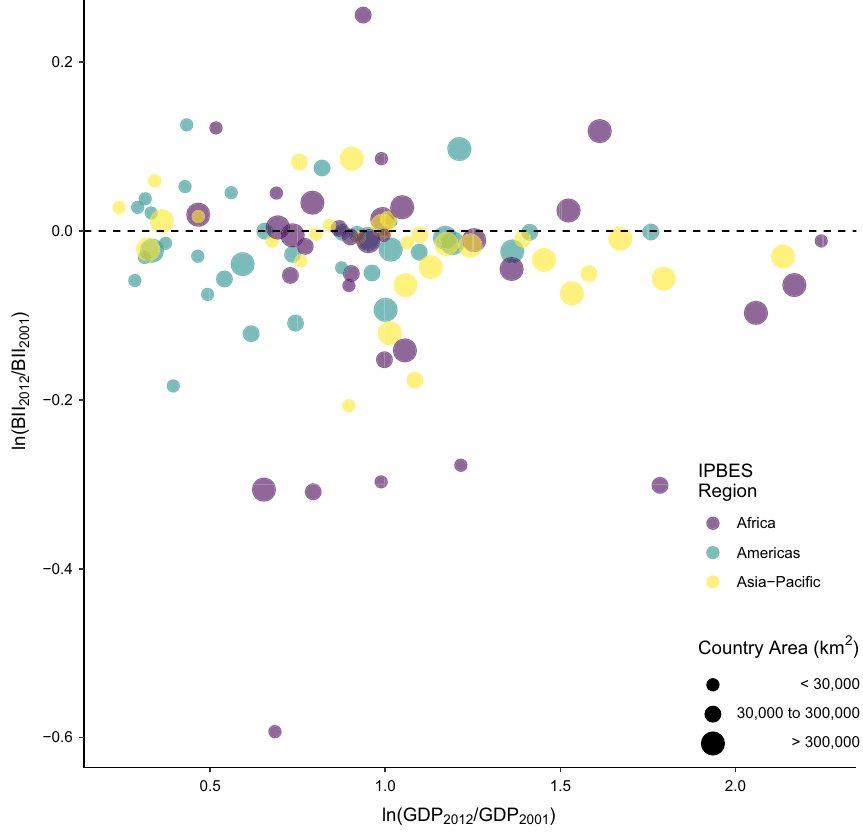
Figure 3. Change in BII over time plotted against the change in Gross Domestic Product (GDP) per capita for each country. Change was calculated as the log-response ratio of 2012 and 2001 values. A value of zero indicates no change, negative values indicate a decline from 2001 to 2012, and positive values indicate an increase between 2001 and 2012. Note that not all countries have available data on GDP per capita for the years 2001 and 2012 so some countries are excluded from this plot. Colours represent the different regions. The circles are scaled according to the country